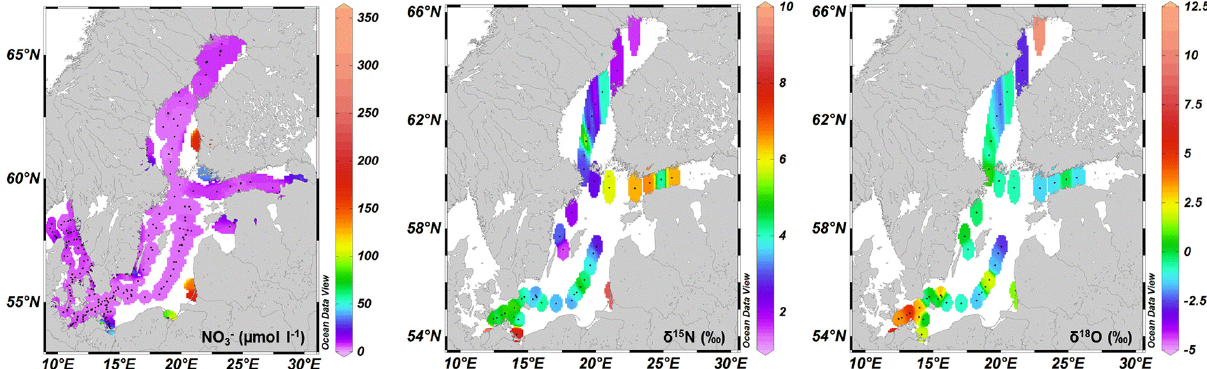
Figure 2. Surface water column NO − indicated as black dots. Additional NO − winter (November–February) of the years 2000 to